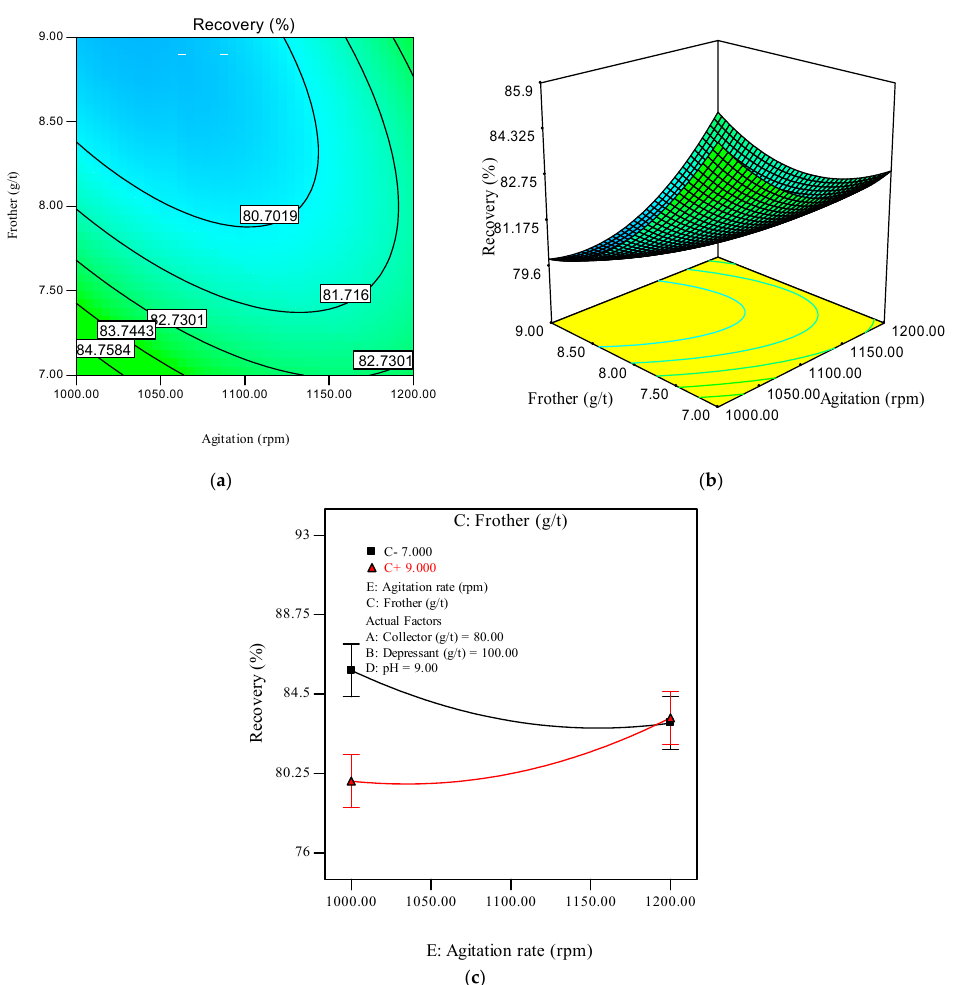
Figure 4. ( a ) Contour and ( b ) 3D response surface plots showing the combined effect of frother and agitation rate and ( c ) their interaction effect on the copper recovery.